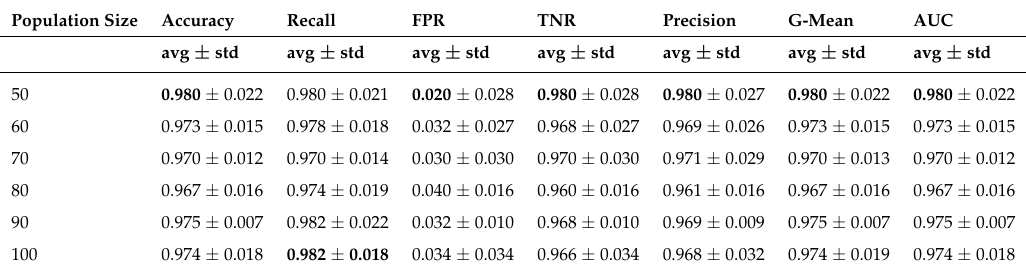
Table 5. The performance evaluation of the SSA at (50%) of the ratio of leaders at different population sizes, in terms of average accuracy, recall, FPR, TNR, precision, g-mean, and AUC.